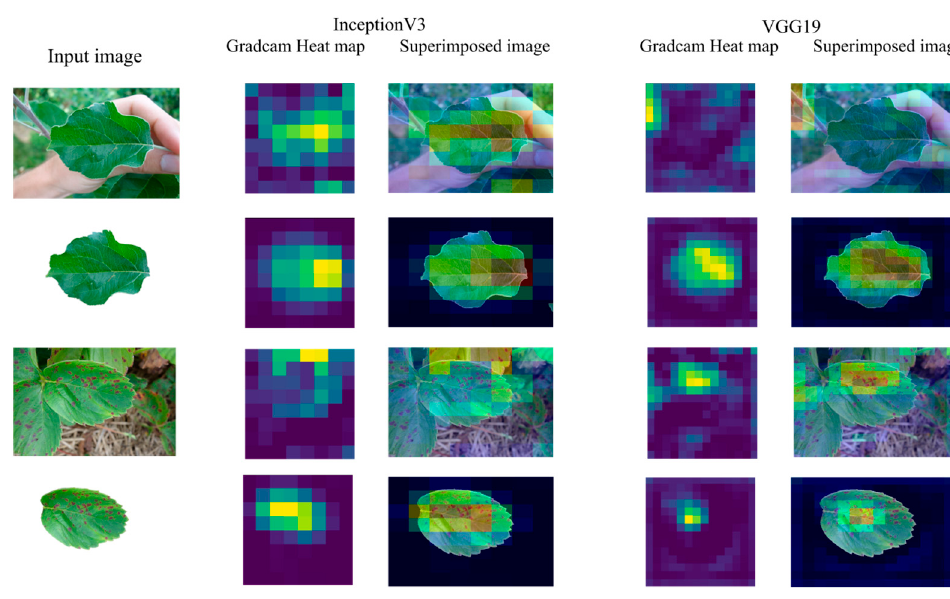
Figure 9. Visualization using Grad-CAM for plant leaf image.